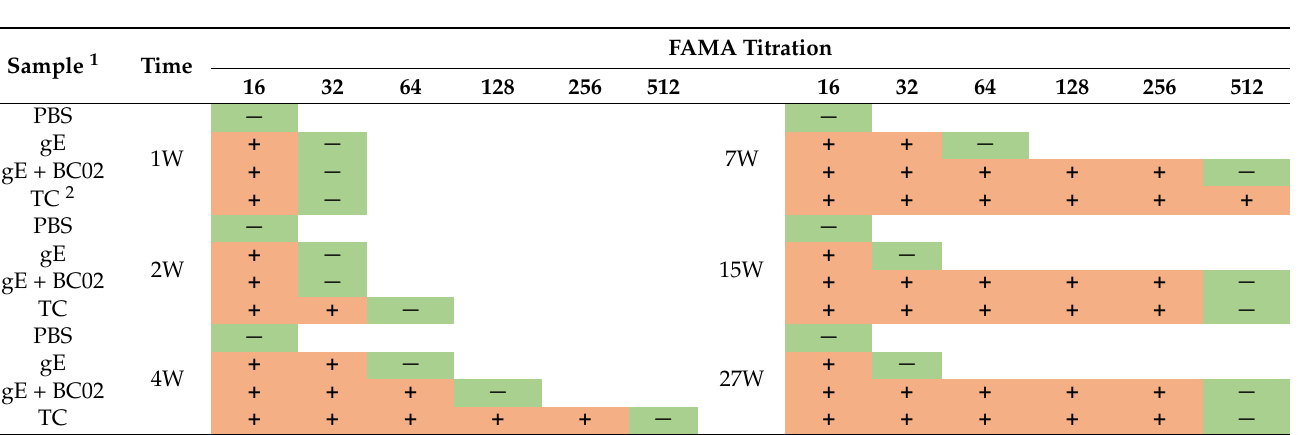
Table 1. Fluorescence signal intensity of mouse serum FAMA assay at different time points and different dilution ratios after immunization.